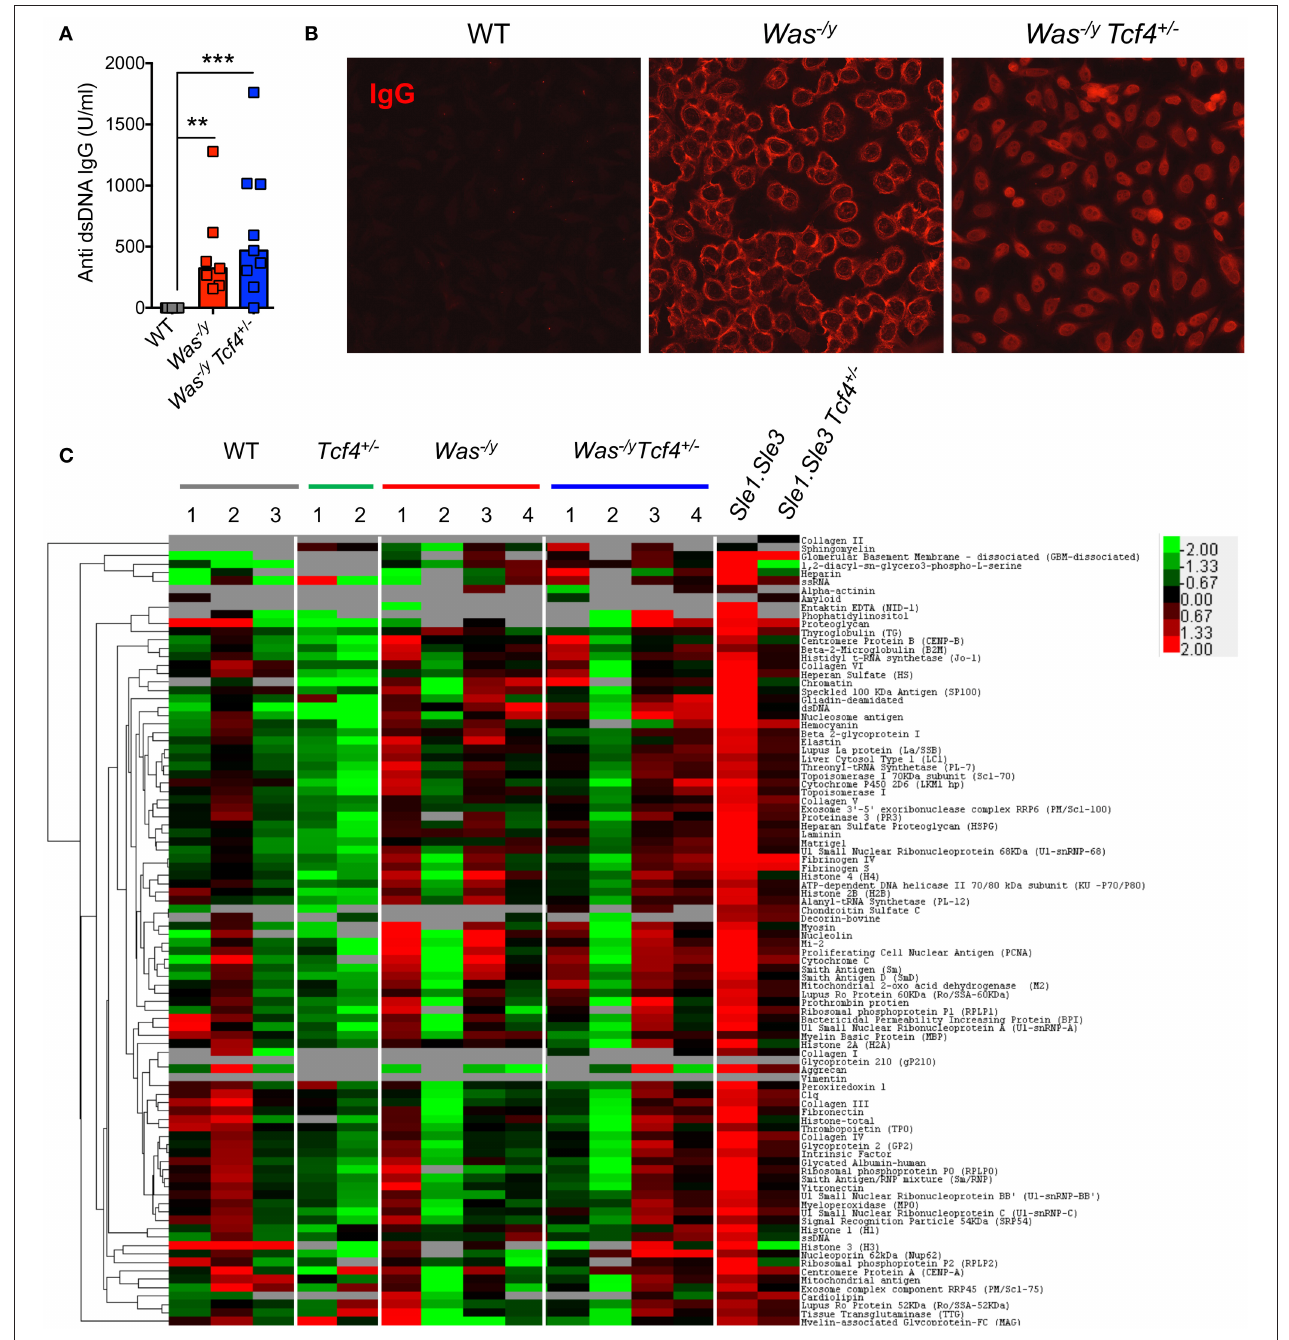
FIGURE 3 | Tcf4 haplodeficiency does not affect autoreactive antibody production in Was -deficient mice. Sera from WT, Was − / y , or Was − / y Tcf4 + / − mice were obtained at 30 weeks of age and analyzed for autoreactive antibody production. (A) Anti-dsDNA IgG levels in the sera of indicated mice were determined by ELISA. Data were pooled from 4 independent experiments and bars represent the median. (B) ANA staining of IgG (red) using fixed Hep-2 cells following incubation with the sera of mice with the indicated genotype as analyzed by fluorescent microscopy. Images are representative of 2 independent staining experiments that include 6 animals for each genotype. (C) IgG autoreactivity in the indicated mice at 30 weeks of age as measured by an antigen array. Shown are heat maps of the relative IgG seroreactivity to the indicated antigens. Statistical significance estimated by Kruskal-Wallis test followed by a post-hoc Dunn’s multiple comparison test is indicated as follows ** P ≤ 0.01, *** P ≤ 0.001.